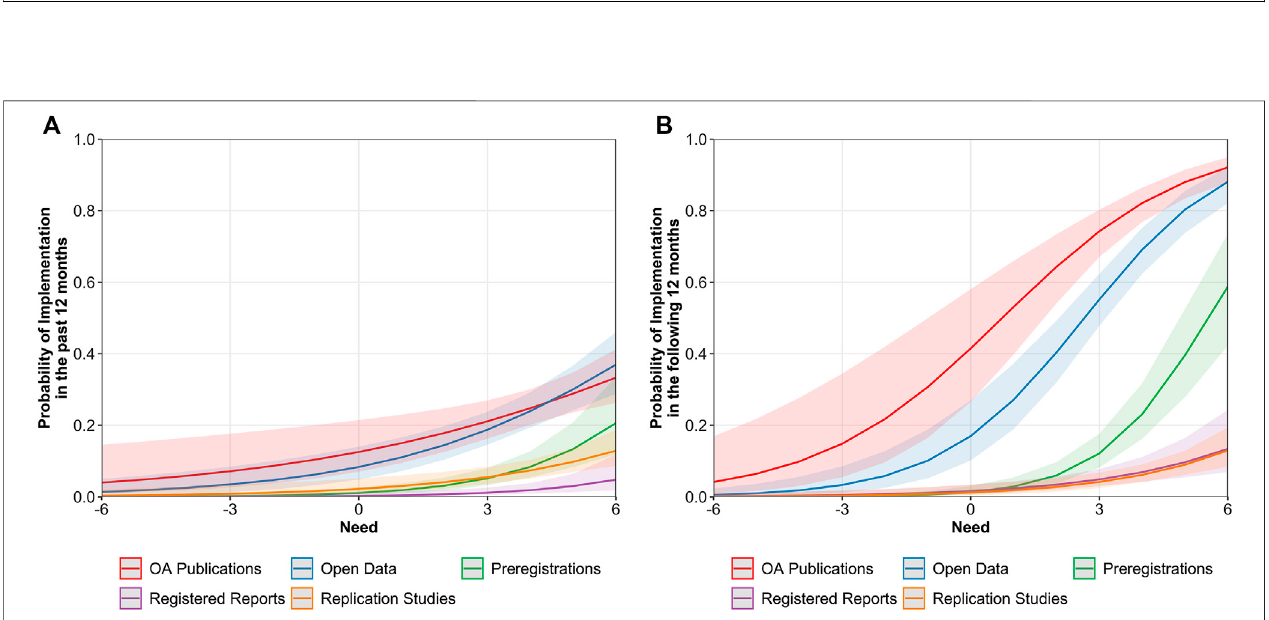
FIGURE 10 | Predicted values of implementation in the past 12 months (A) and in the following 12 months (B) as a function of ECRs ’ perceived need across OS practices. Bandwidths represent 95% con fi dence intervals (CIs).